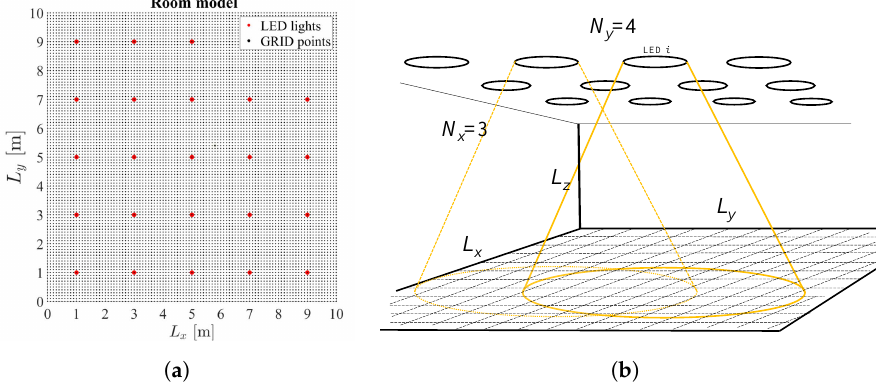
Figure 1. Considered system model: ( a ) the grid model of the ceiling with the LED lamp positions (red dots); ( b ) 3D indoor office